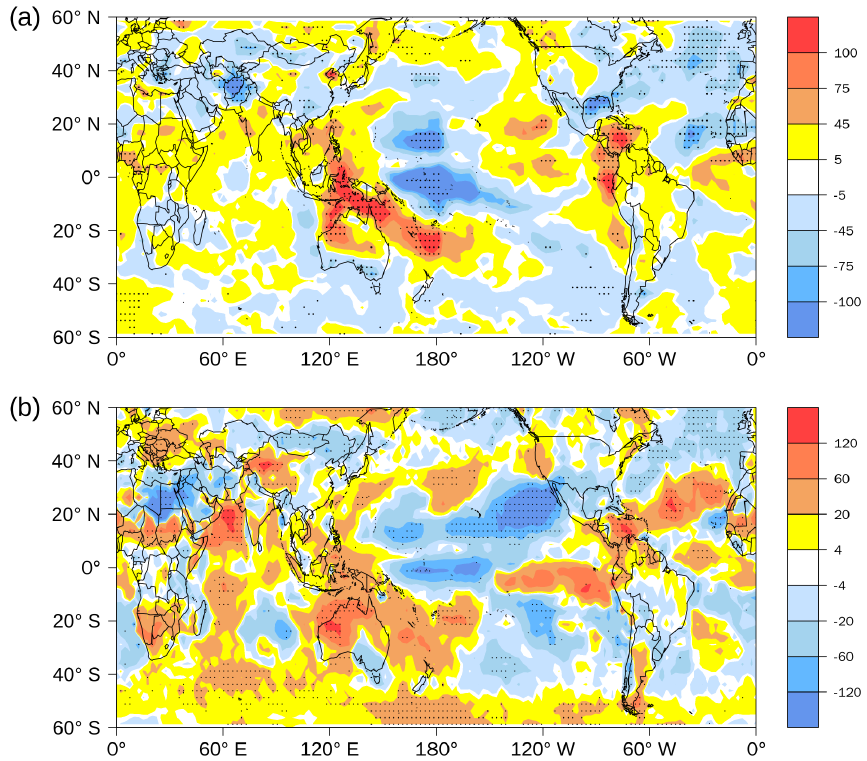
Figure 5. (a) Slope of linear regression between total cloud cover and AMO (units: %K − 1 ) at individual grids from the corrected ISCCP D2 data set (1983–2009). (b) Slope of linear regression between annual total precipitation and AMO (units: %K − 1 ) at individual grids from GPCP pentad V2.2 (1983–2009). Dots indicate changes significant at the 95% confidence